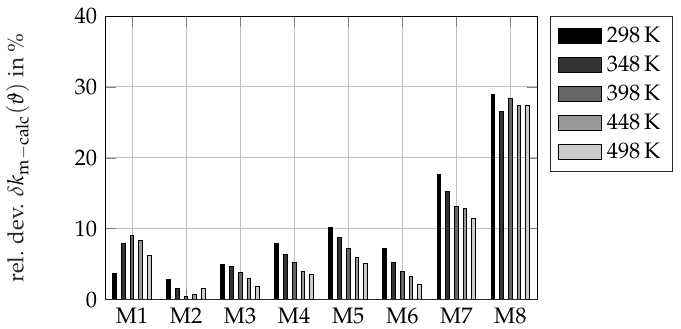
Figure 13. Relative difference between thermal conductivites gained from measurement and analyti- cal formula δ k m − calc ( ϑ )